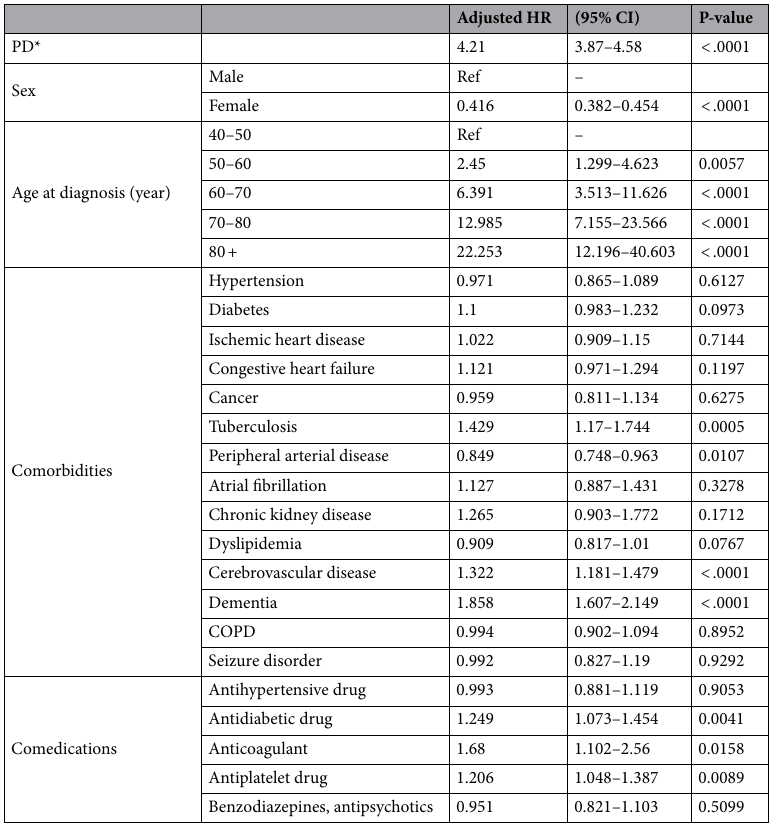
Table 3. Cox proportional hazard model for risk factors of aspiration pneumonia. PD Parkinson’s disease, HR hazard ratio, CI confidence interval, COPD chronic obstructive pulmonary disease. *Adjusted for age group, sex, region of residence, the Charlson comorbidity index score, comedications and comorbidities.